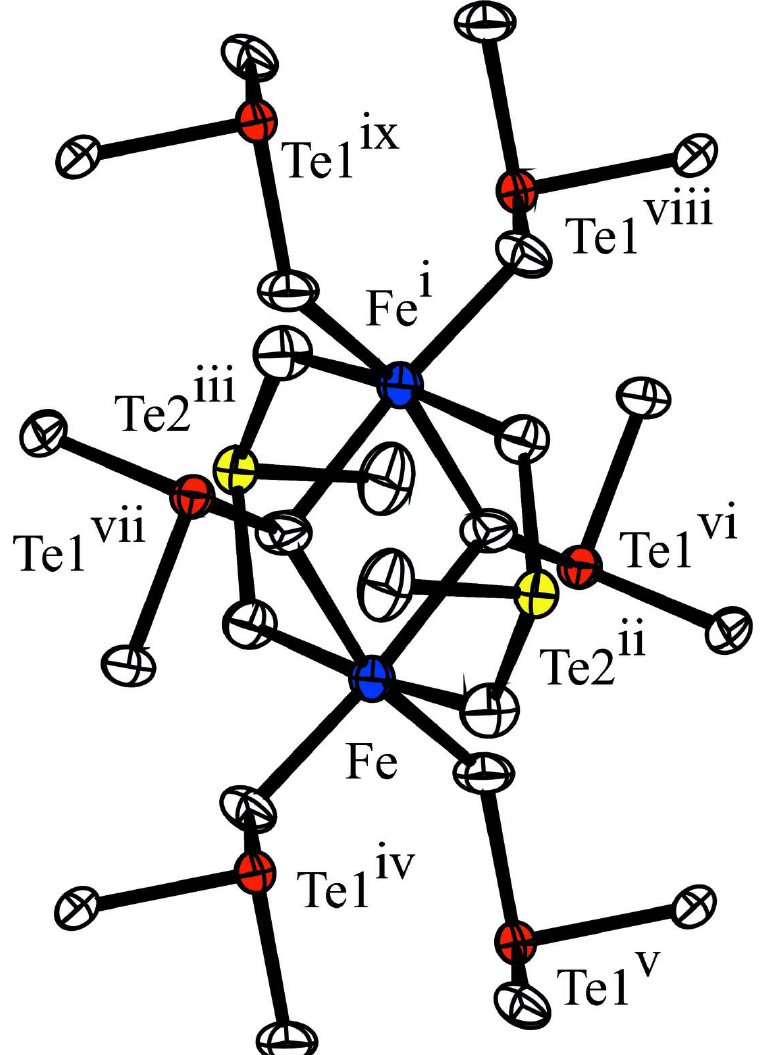
O ] dimer with the corner-sharing TeO trigonal-pyramids attached. Atoms are drawn as displacement ellipsoids The [Fe 2 10 3 at the 90% probability level. [Symmetry operators: (i) - x + 1, - y + 1, z ; (ii) - x + 1/2, y + 1/2, - z + 1; (iii) x + 1/2, - y + 1/2, z - 1; (iv) x - 1/2, - y + 1, - z + 1/2; (v) - x + 1/2, - y + 1/2, z - 1; (vi) - x + 1, - y + 1/2, z - 1/2; (vii) x , y + 1/2, - z + 1/2; (viii) - x